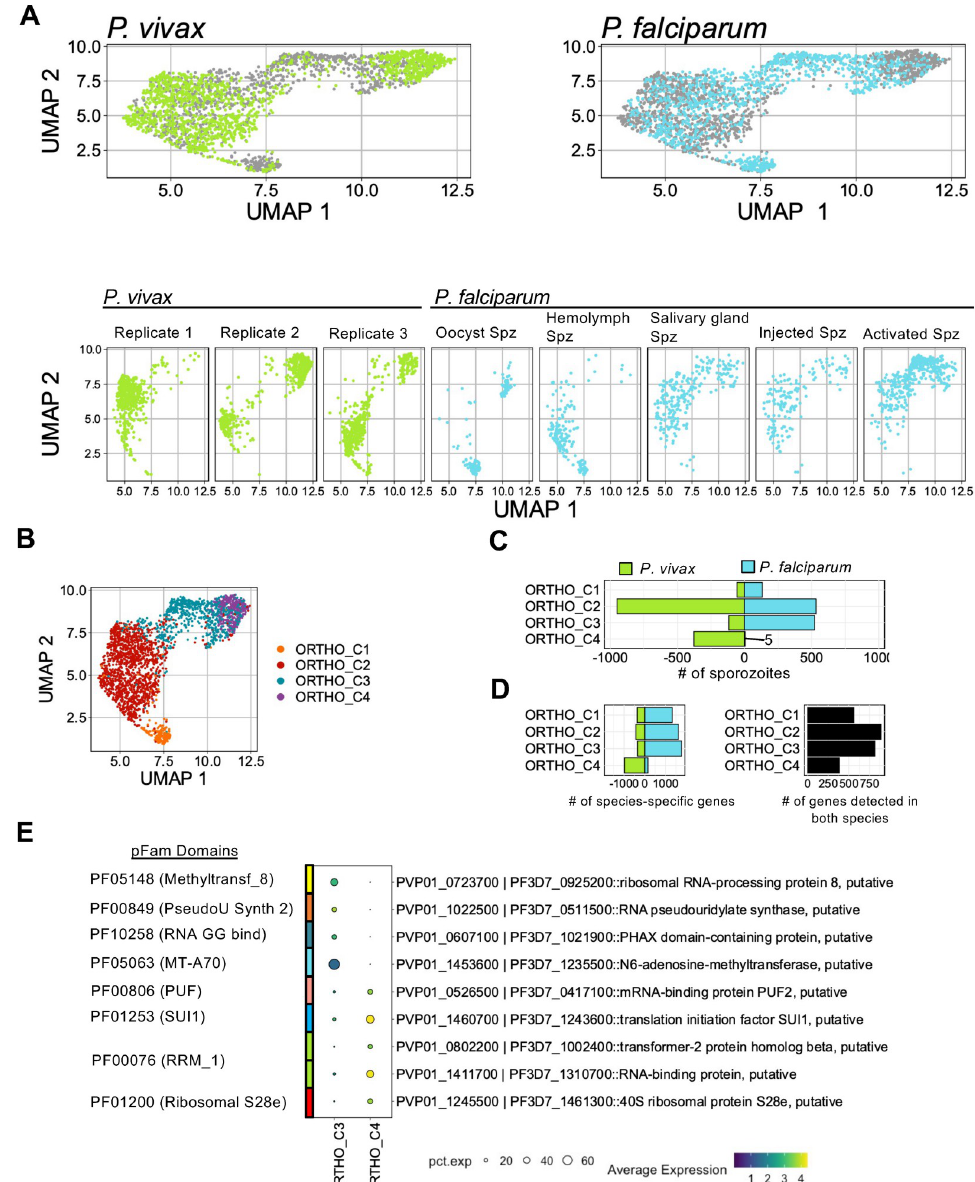
Fig 5. Integration of P . vivax and P . falciparum sporozoite datasets. (A) UMAPs of integrated P . vivax and P . falciparum data. Top: split and coloured by species. Bottom: split by replicate ( P . vivax ) or sporozoite status ( P . falciparum ). (B) UMAP of integrated P . vivax and P . falciparum data coloured by cluster. (C) Number of cells contributing to each cluster from P . vivax and P . falciparum samples. (D) Number of species-specific genes (left) and conserved one-to-one orthologs (right) detected in each cluster. (E) Differentially expressed genes between clusters ORTHO_C3 and ORTHO_C4 with known RNA-binding Pfam domains. Scale bar: normalised expression.